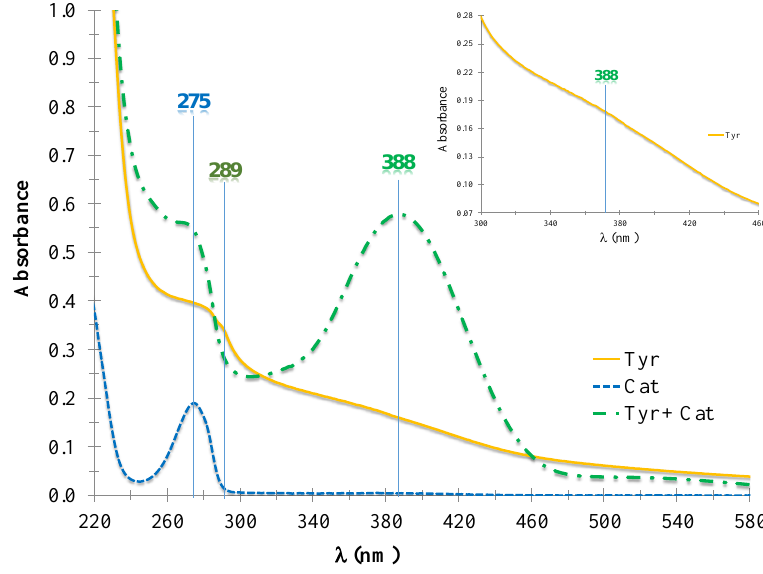
Figure 1. Absorption spectra of the mushroom tyrosinase (Tyr) 145 µg·mL −1 ( Solid line ), catechol (Cat) 118 µM ( Broken line ) and the reacting system Tyr + Cat; each spectrum was obtained in 0.1 M acetates’ buffer at (30.0 ± 0.5) °C and at pH 4.50 ± 0.01. The inset shows a close-up of the Tyr absorption spectrum.